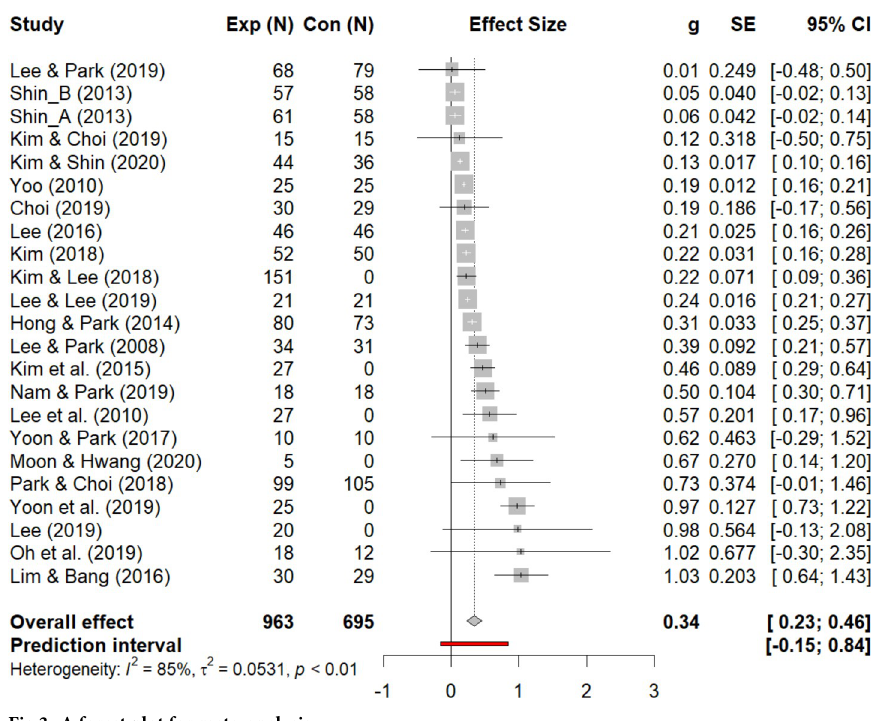
Fig 3. A forest plot for